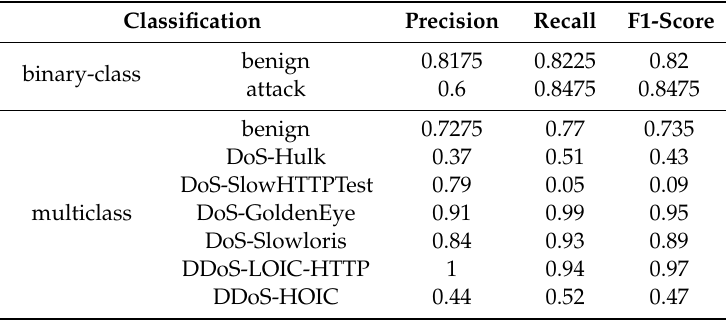
Table 12. Accuracy of the RNN model in case of CSE-CIC-IDS